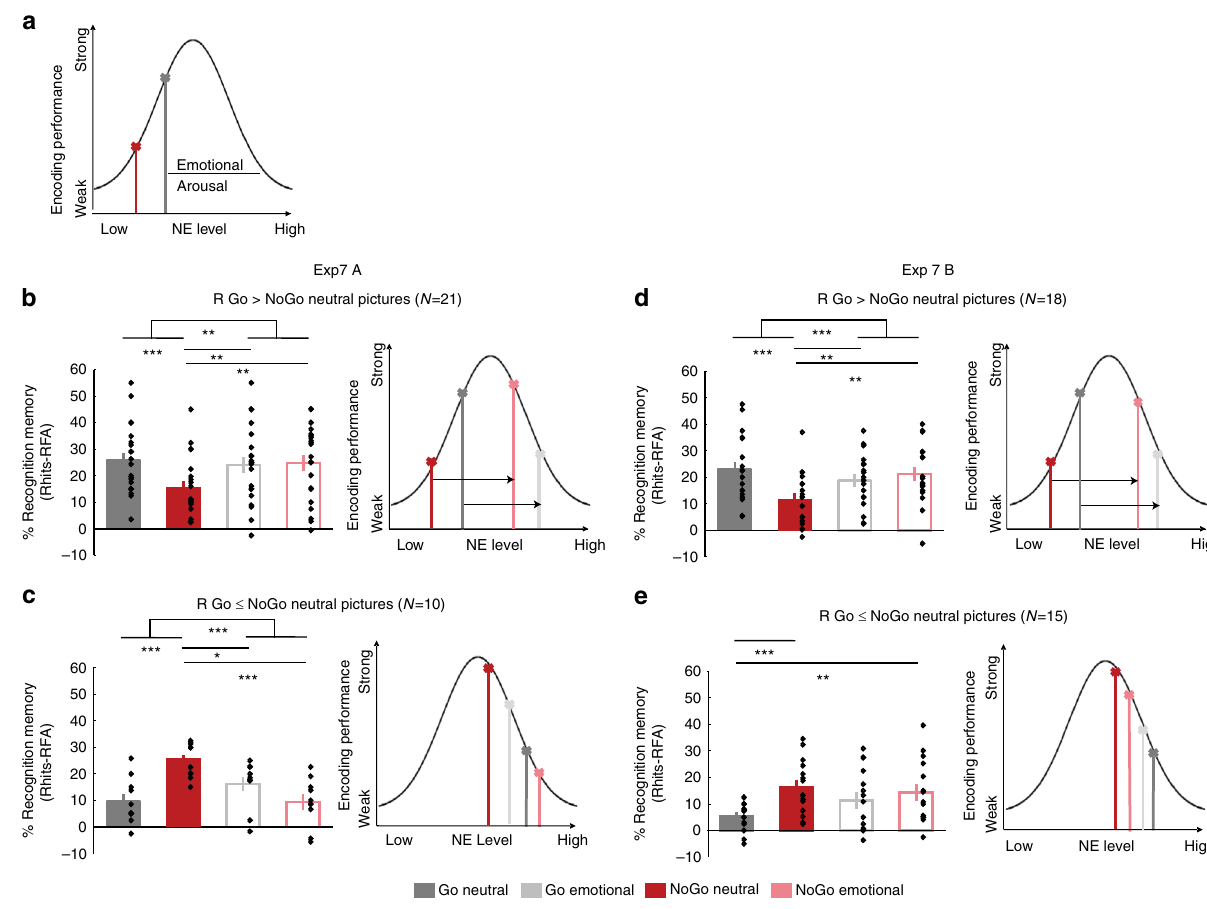
Fig. 5 AIME is modulated by emotion. a Schematic “ inverted-U ” relationship between encoding performance and norepinephrine (NE) level, with putative locus of Go and NoGo encoding for emotionally neutral stimuli indicated on this curve. We hypothesized that emotion would shift memory scores to the right. b , c Exp 7 Recognition memory for remembered items (R) corrected for false alarm rates for Go and NoGo neutral and emotional trials (left) and the schematic (right) for participants that show AIME for the neutral stimuli ( n = 21) ( b ) and those that do not ( n = 10) ( c ). d , e Same as ( b , c ) for